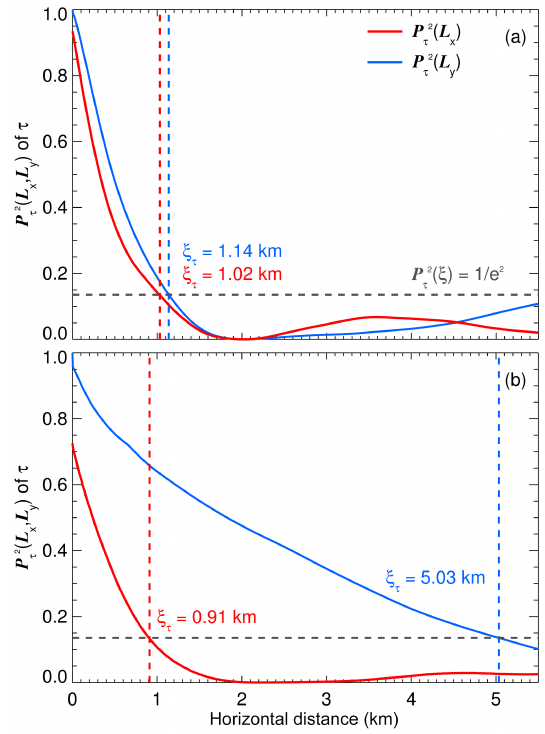
Figure 3. (a) Average of squared 1-D autocorrelation functions P 2 τ (L x ,L y ) (solid lines) calculated for pixels, which are orientated into the direction of the blue ( L x ) and red lines ( L y ) illustrated in Fig. 2b. The dashed lines mark the derived distance of the decorre- lation length ξ τ , where P 2 τ (L x ) and P 2 τ (L y ) are decreased to 1 /e 2 . (b) Same as panel (a) for P 2 τ (L x ,L y ) shown in Fig.